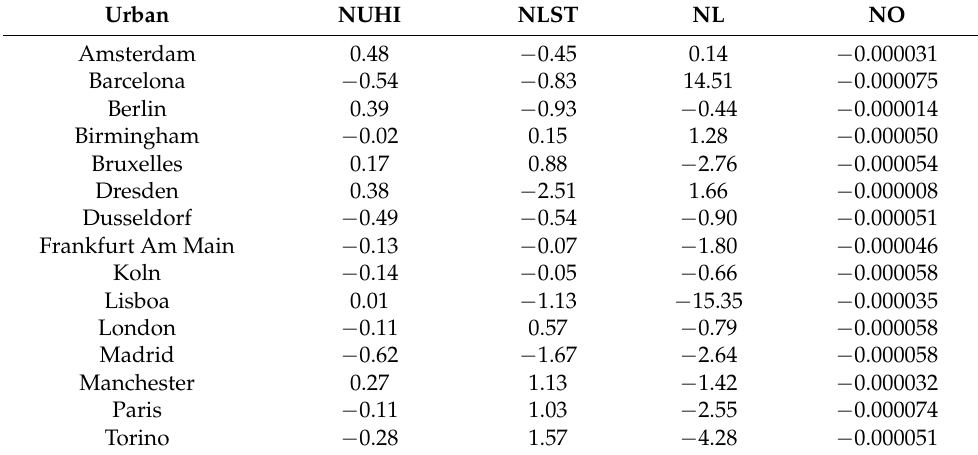
Table 8. Differences in NUHI, NLST, NL, and NO 2 changes during the lockdown compared to its previous year in European major cities.